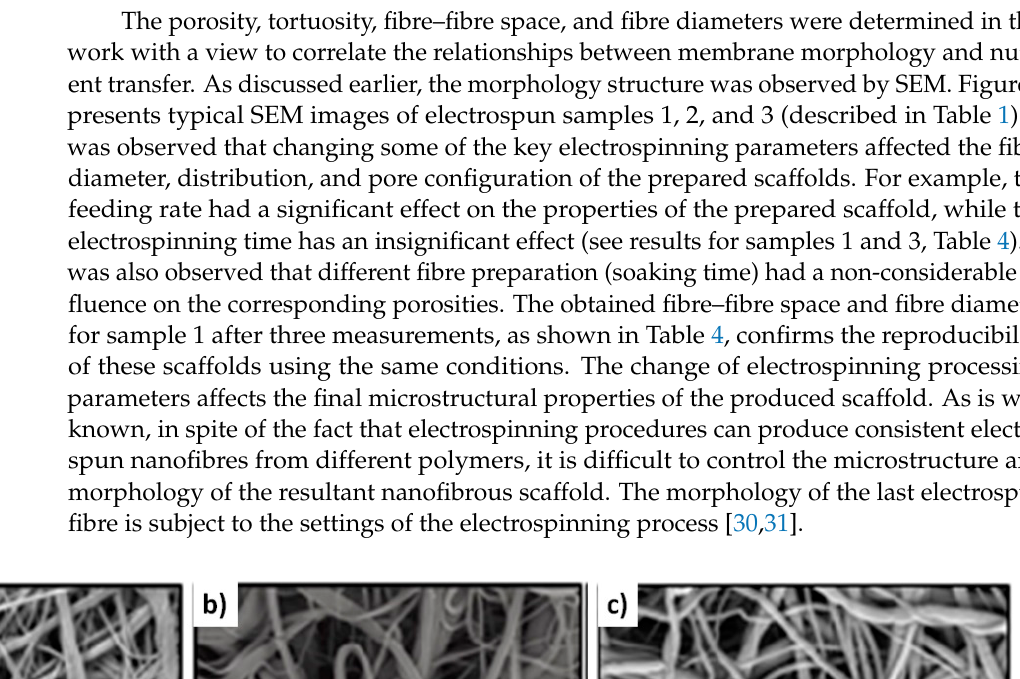
Table 4. Average fibre-fibre space and fibre diameter of electrospun scaffolds.